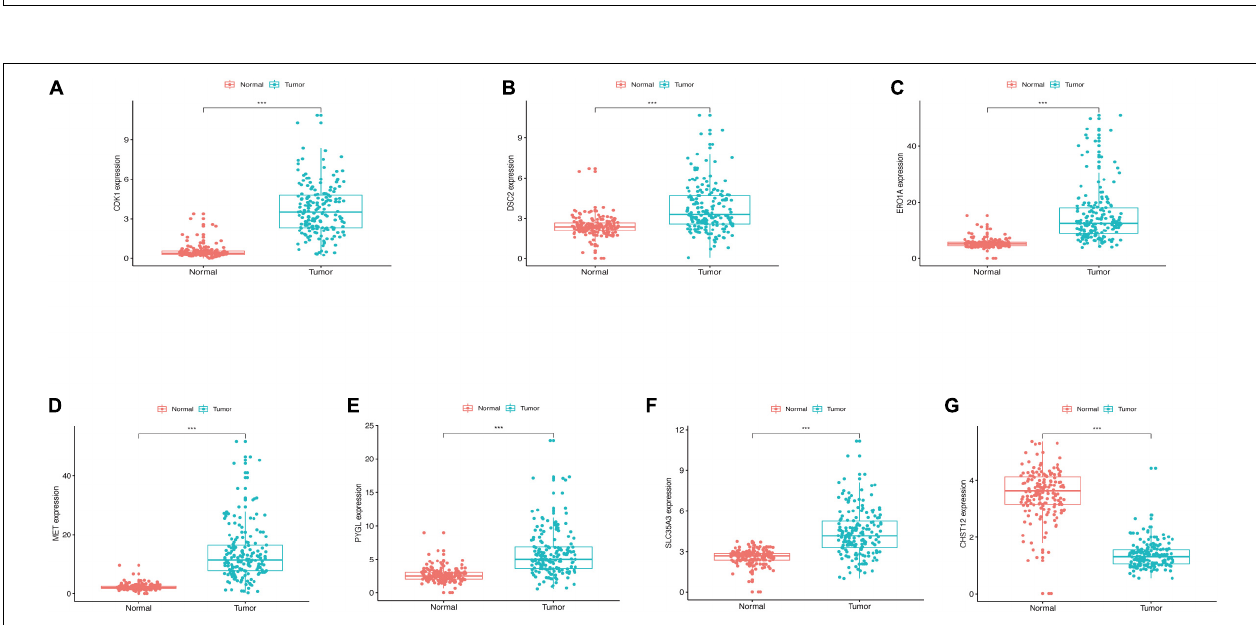
FIGURE 5 | (A) Expression of CDK1 in PDAC and normal tissues. (B) Expression of DSC2 in PDAC and normal tissues. (C) Expression of ERO1A in PDAC and normal tissues. (D) Expression of MET in PDAC and normal tissues. (E) Expression of PYGL in PDAC and normal tissues. (F) Expression of SLC35A3 in PDAC and normal tissues. (G) Expression of CHST12 in PDAC and normal tissues. *** p < 0.001.